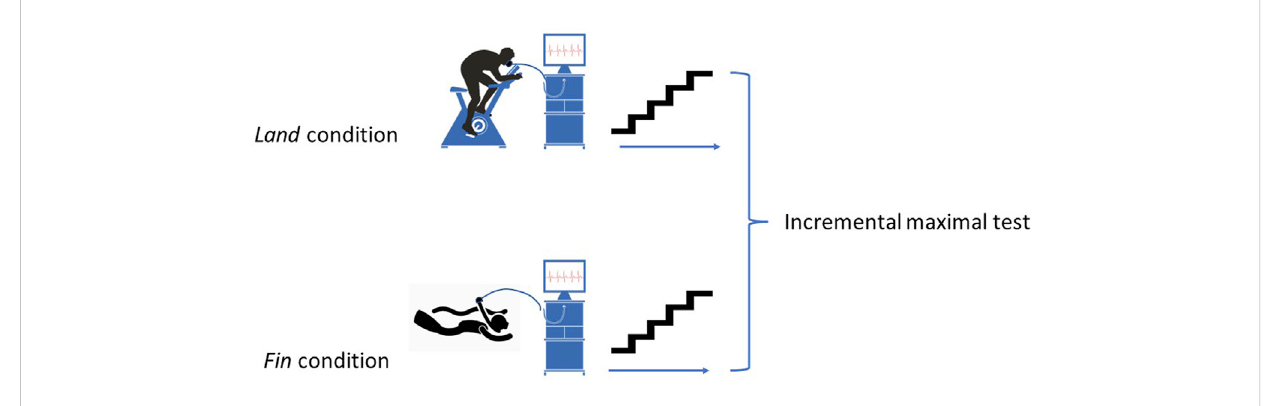
FIGURE 1 Schematic representations of experimental